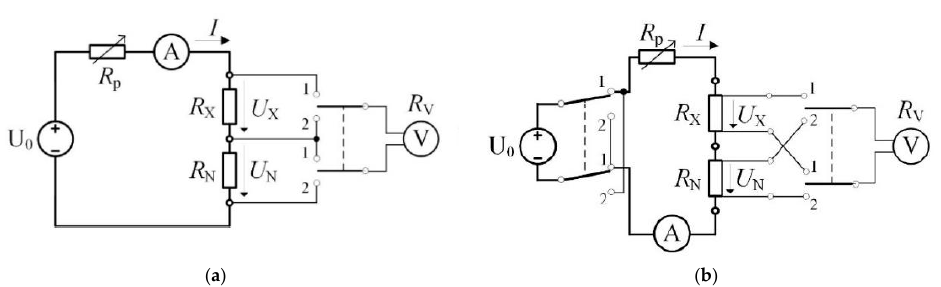
Figure 3. Wiring diagrams that are implemented in practice for the direct comparison method using a standard resistor and voltmeter: ( a ) two-terminal and ( b ) four-terminal connection. If voltages U X and U N are measured simultaneously using the same high-resolution voltmeter while maintaining the same measuring range and without changing the current intensity during the measurement, the systematic effects in measuring these voltages can be neglected (Figure 1). In this case, no correction of the calculated value of the unknown resistance R X is required, which can be derived from (2), as corroborated by the following